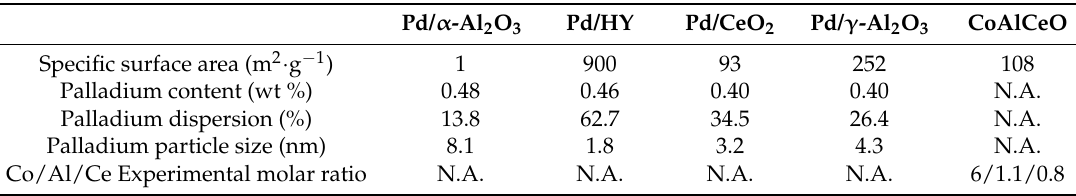
Table 1. Characterization of the studied catalytic